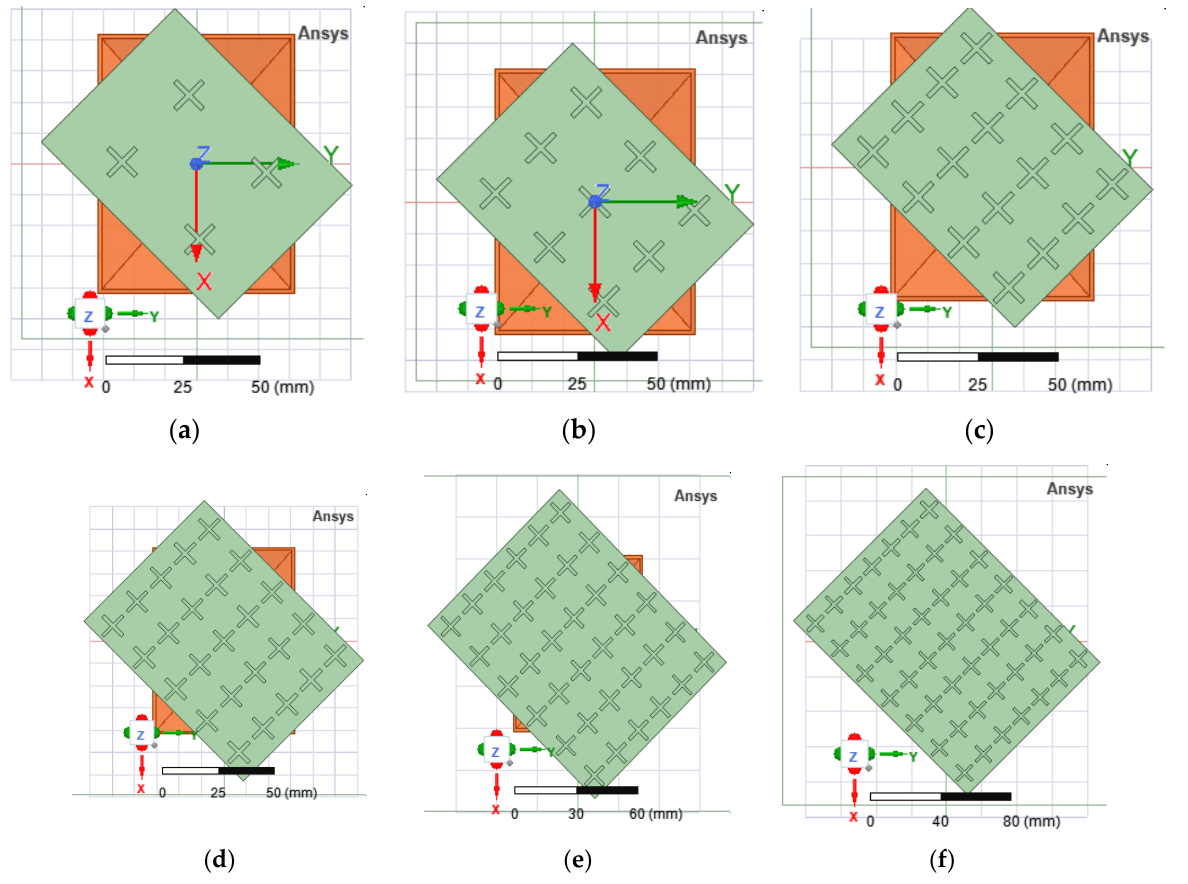
Figure 10. FSS structures with N × N elements in the aperture of the horn antenna. Table 1. Figures of merit for the radiating system consisting of a horn antenna and a single-layer FSS structure with N × N